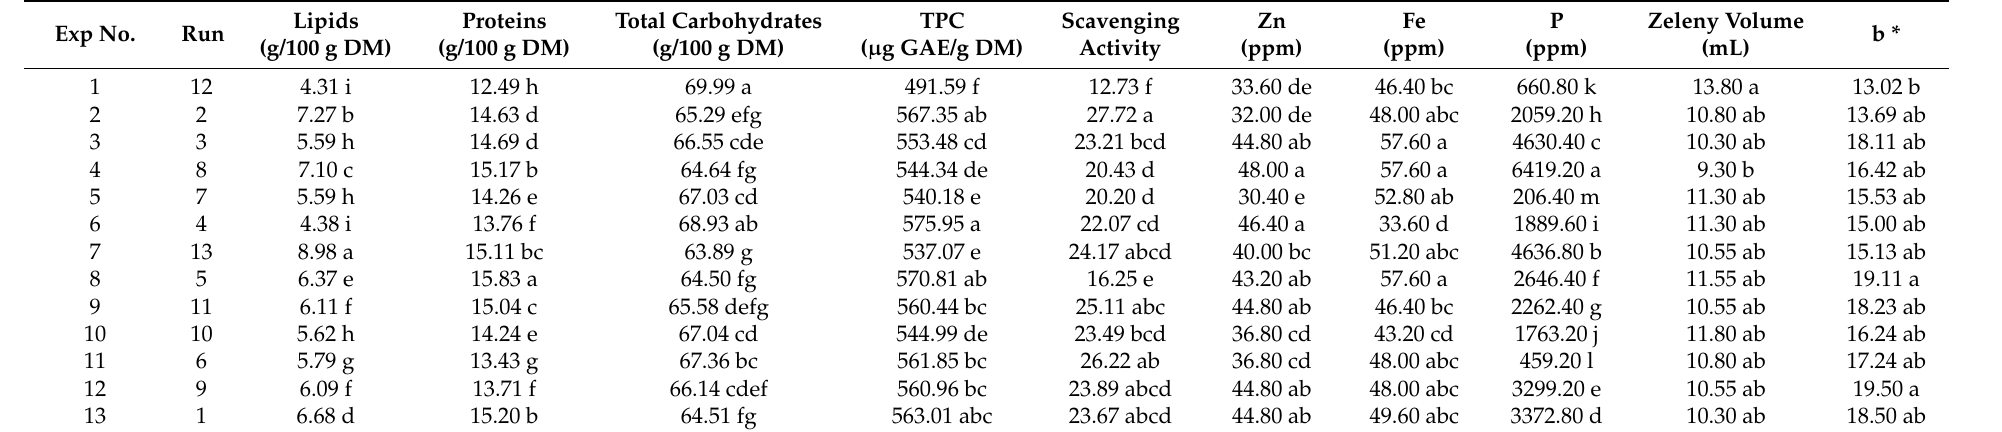
Table 2. Nutritional and technological quality parameters of design mixture experiments with wheat–chickpea–milk powder composite flours. Exp